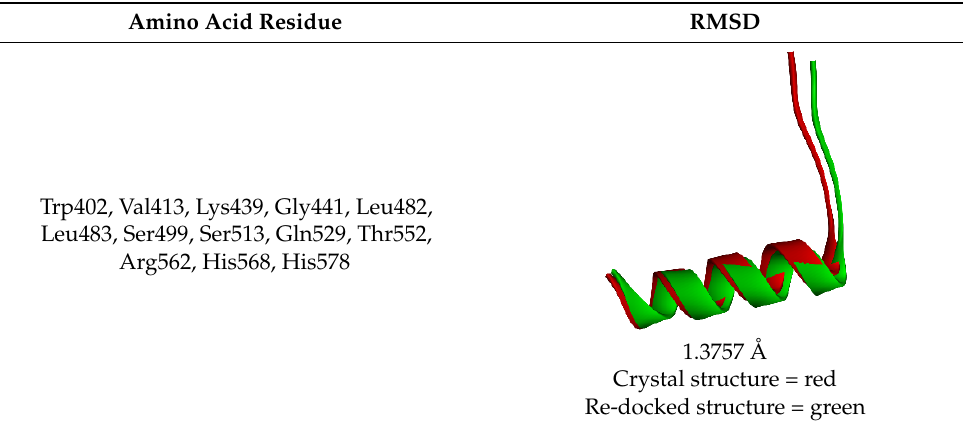
Table 3. Results of the validation of the protein-peptide docking method.